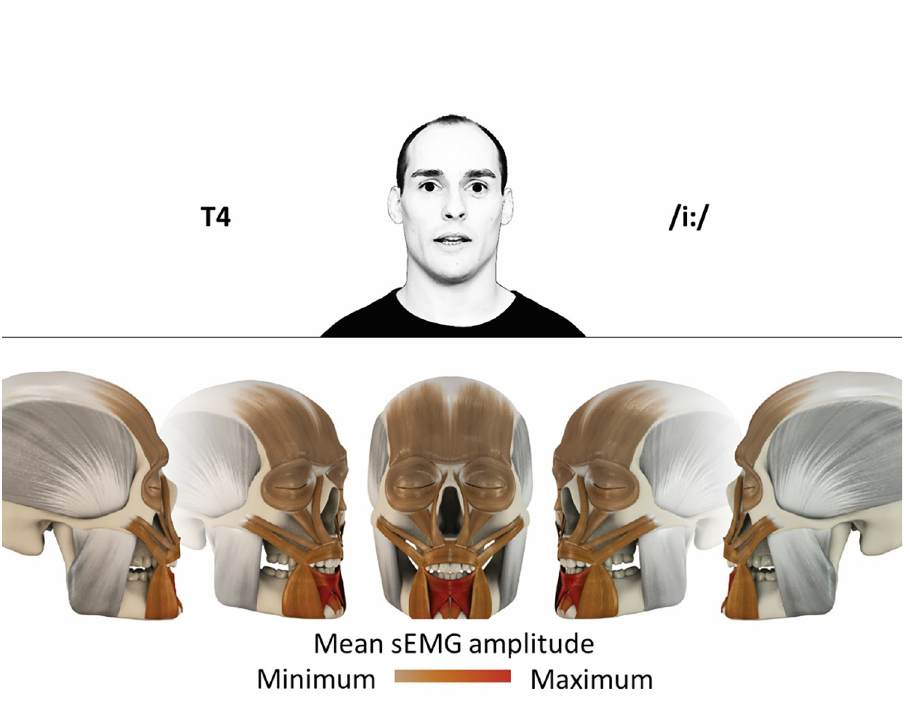
Fig 5. Color-coded facial muscle activation pattern of task T4. Pronouncing the German vowel: I/i ː /. Animation by Jonas Laustro¨er.